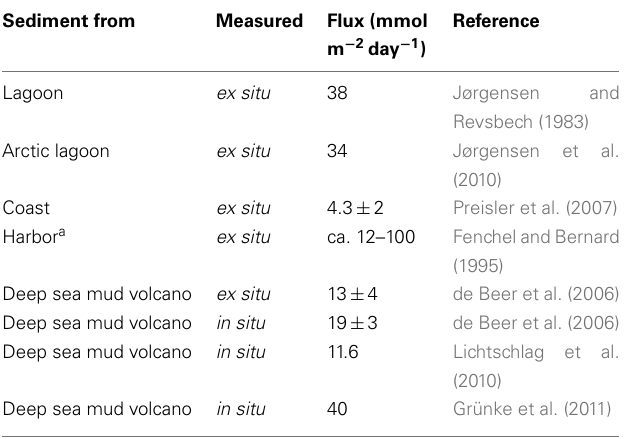
Table 2 | Diffusive sulfide fluxes in natural Beggiatoa spp. mats. Sediment from